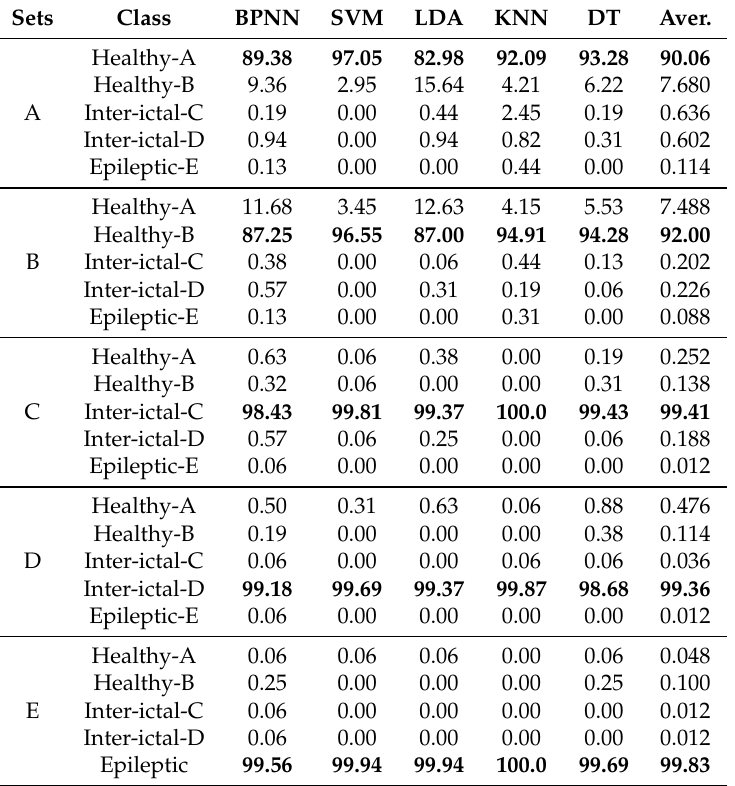
Table 6. Classification results of the five classifiers on all five data-sets of Case 4 (Back-Propagation Neural Network (BPNN), Support Vector Machine (SVM), Linear Discriminant Analysis (LDA), K-nearest neighbour (KNN), Decision Tree (DT), average value